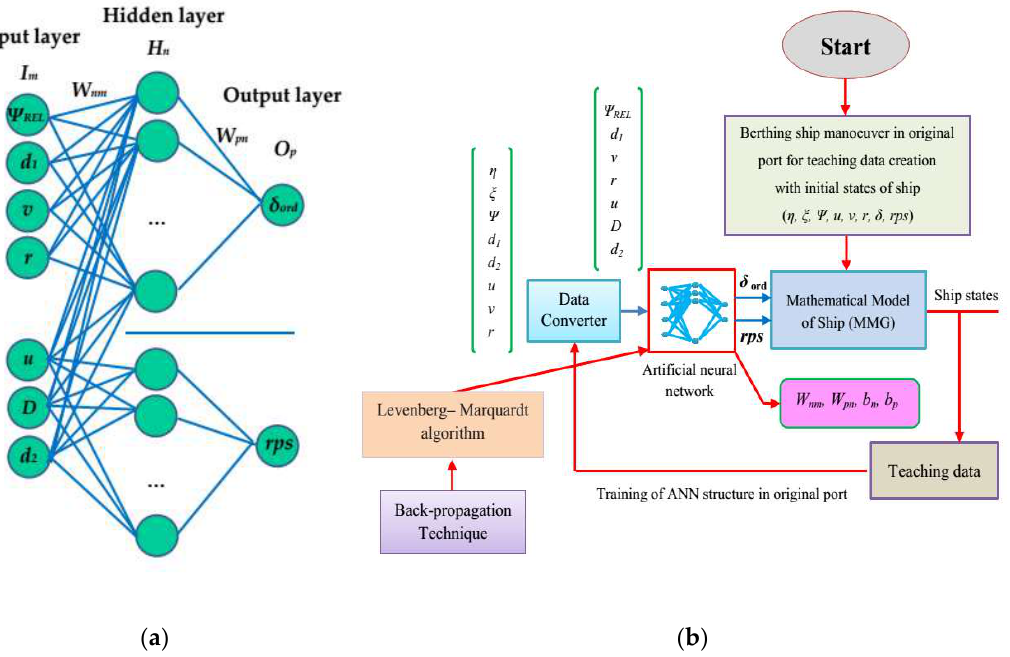
Figure 5. The scheme of training an ANN in the original port: ( a ) the structure of an ANN; ( b ) the method of training an ANN.